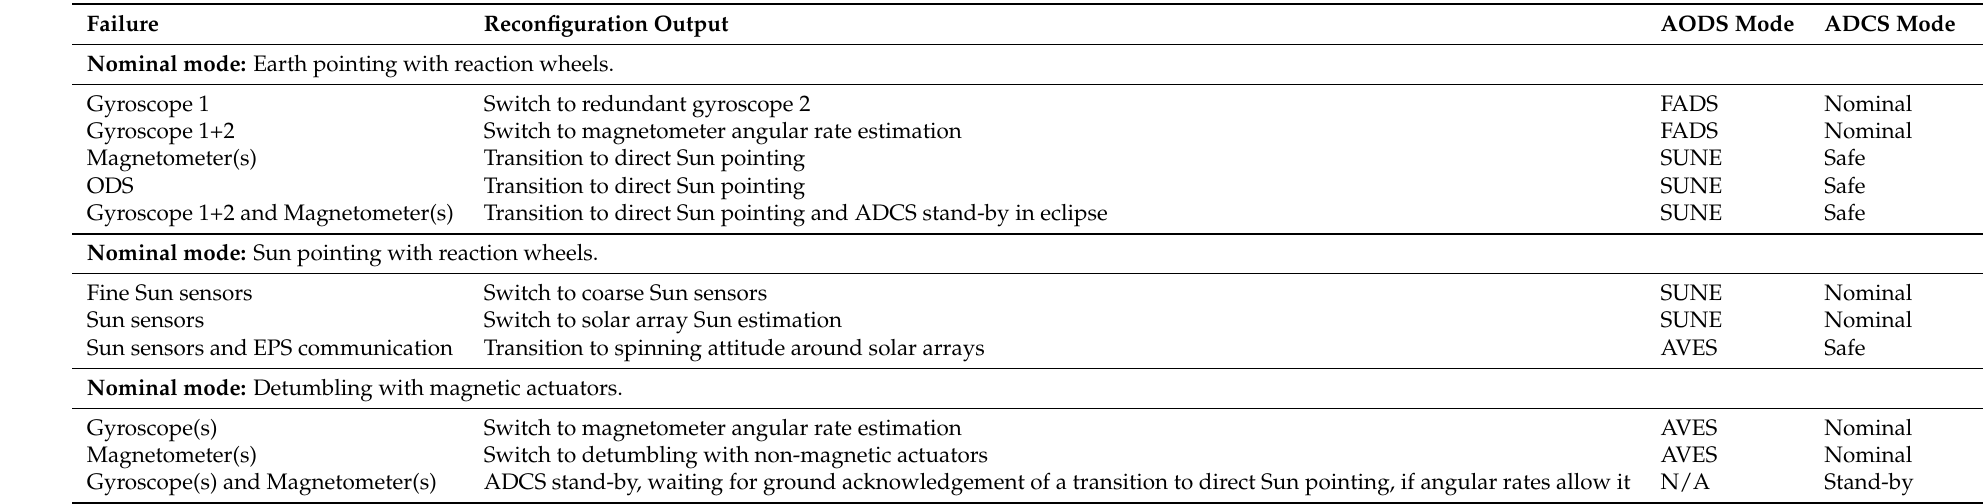
Table 1. Reconfiguration table